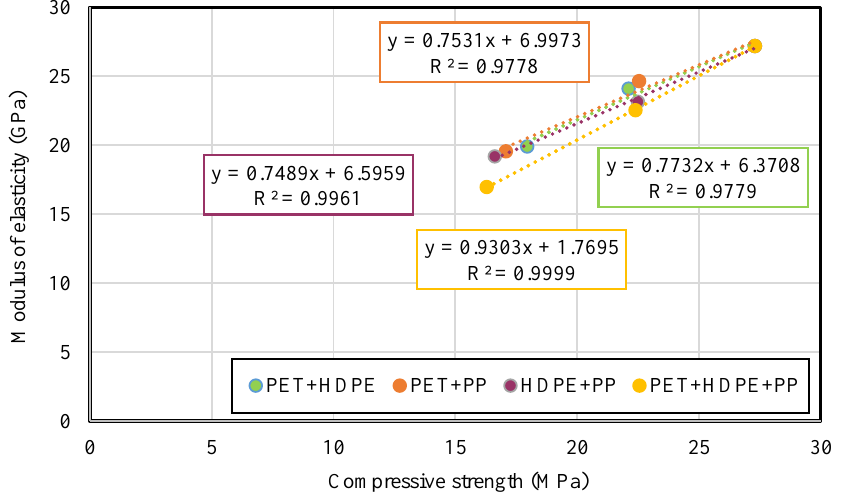
Figure 10. The relationship between the compressive strength and modulus of elasticity.